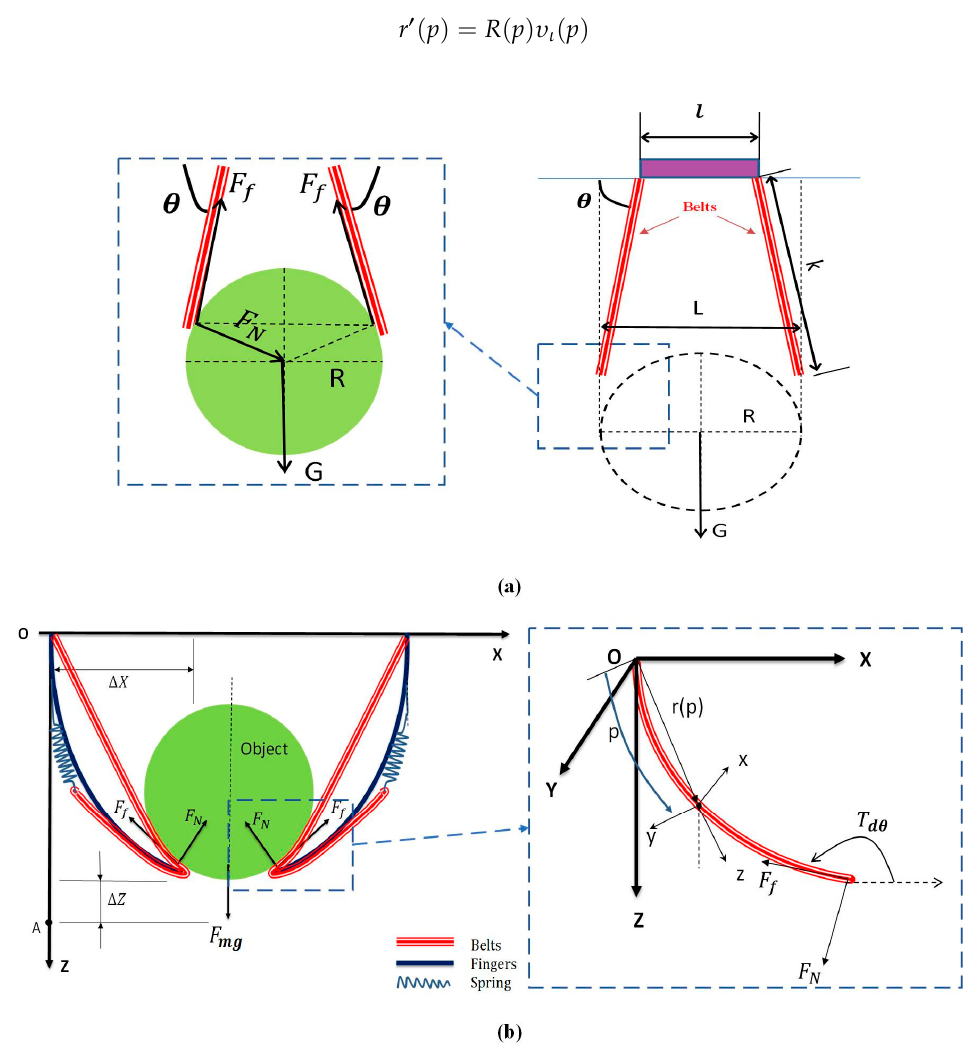
Figure 2. Mechanical analysis diagram of manipulator. ( a ) The maximum grasping size. ( b ) Force and the coordinate of the belts.